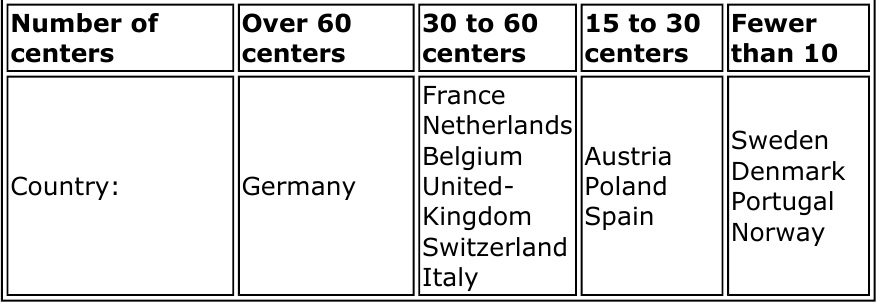
The listing is for